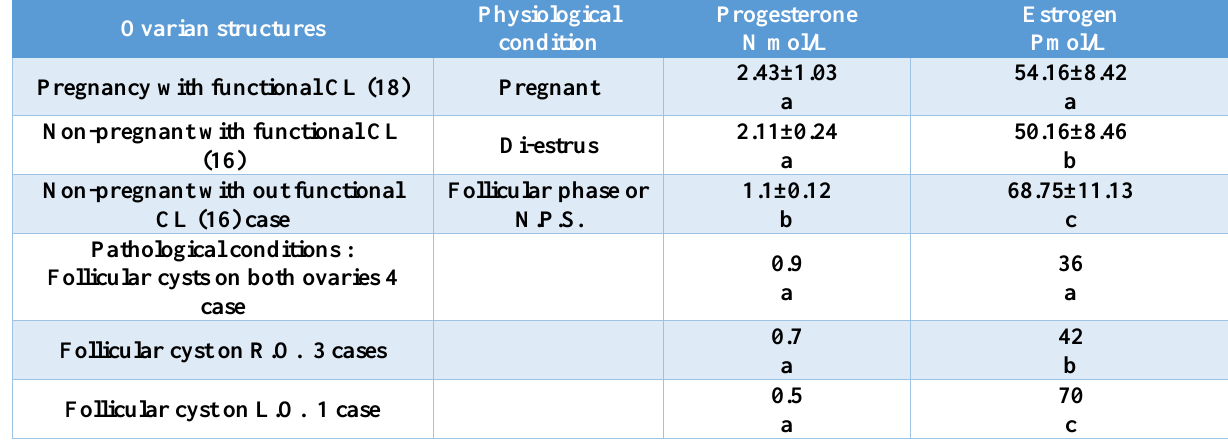
Physiological condition Di-estrus Follicular phase or